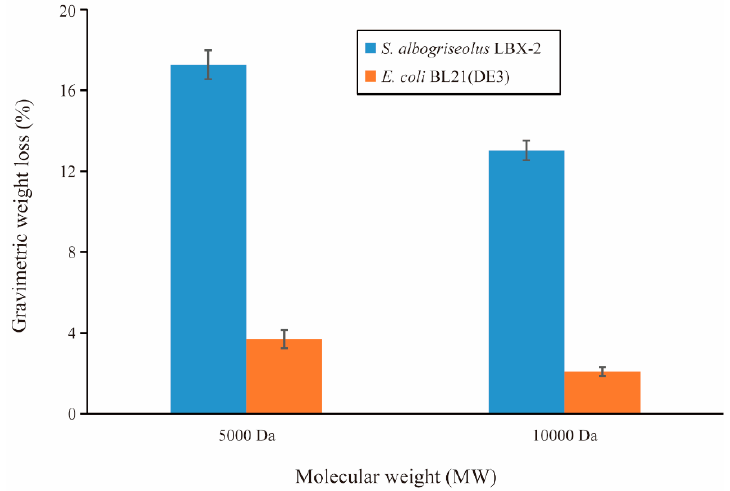
Figure 4. PE biodegradation by strains LBX-2 and E. coli BL21(DE3). Changes in the gravimetric weight of the PE powder over the 15-day period (mean value ± standard deviation (SD), n = 3).